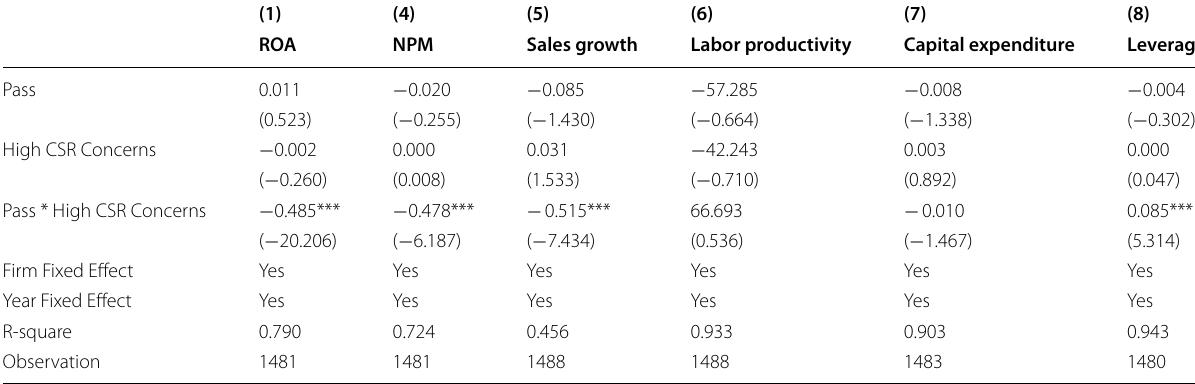
This Table presents the long-term effect of passing a CSR proposal on firm in high CSR concerns group measured by KLD CSR concerns. Return on assets (ROA) is the ratio of operating income before depreciation to the book value of assets. Return on equity (ROE) and net profit margin (NPM) is defined similarly except that the denominator is the book value of equity plus deferred taxes and investment tax credit for ROE and sales for NPM. Tobin’s Q is the ratio of the market value of total assets (book value of assets plus the market value of equity minus the sum of the book value of equity plus deferred taxes and investment tax credit) to the book value of assets. Labor productivity is the ratio of sales to the number of employees. Capital expenditures are the ratio of capital expenditures to total assets. Sales growth is the growth in sales compared with the previous fiscal year. Leverage is the ratio of debt in current liabilities and long-term debt to total assets. All ratios are winsorized at 5%. All models control for firm fixed effects and year fixed effects. Standard errors in parentheses are clustered at the firm level. Significance at the 10%, 5%, and 1% levels is indicated